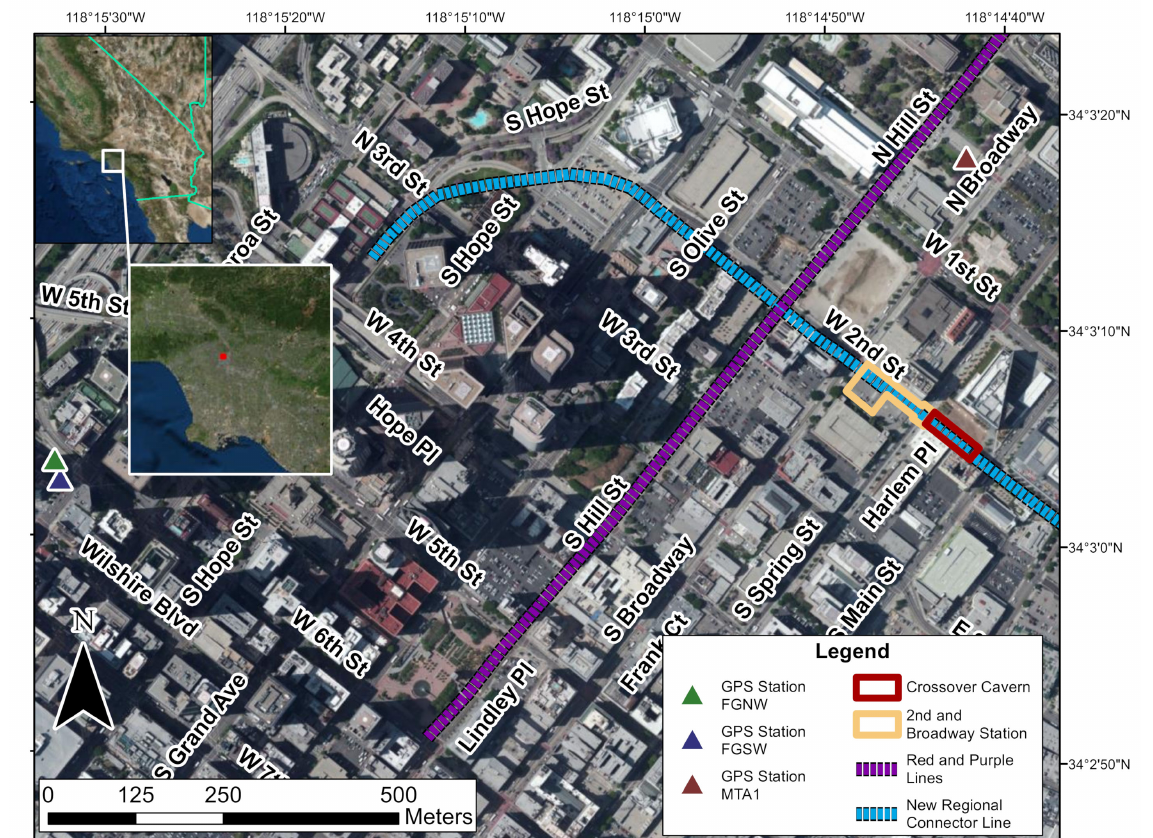
Figure 1. Los Angeles study area, located at the red point in the inset image. Also shown are the subway extension and nearby GPS stations. Background images from Esri, DigitalGlobe, GeoEye, Earthstar Geographics, CNES/Airbus, USDA, USGS, AeroGRID, IGN, and the GIS user